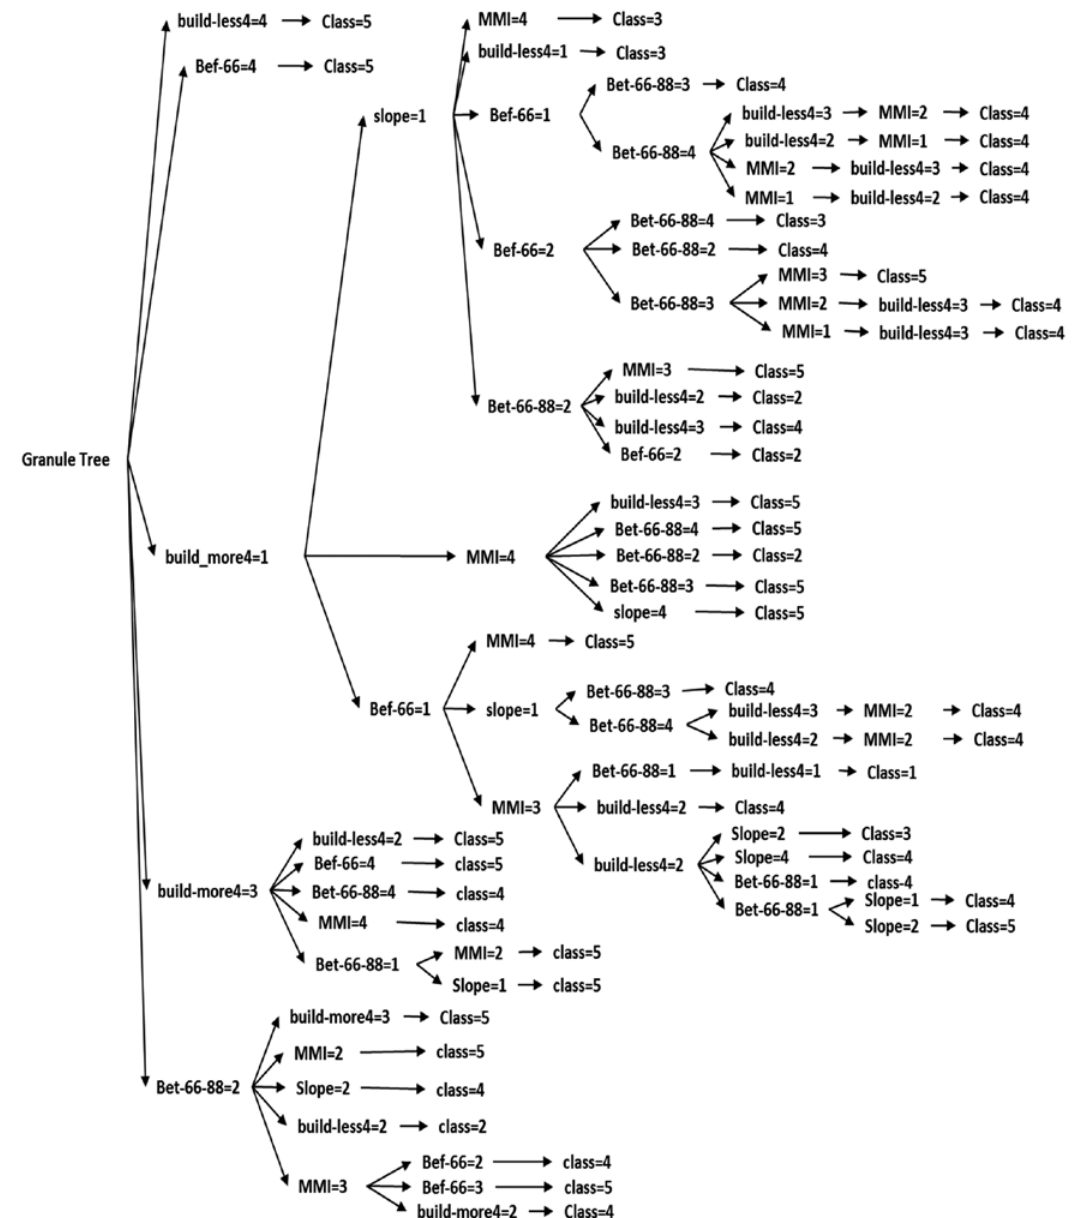
Fig. 2. The granule tree for extracting association rules